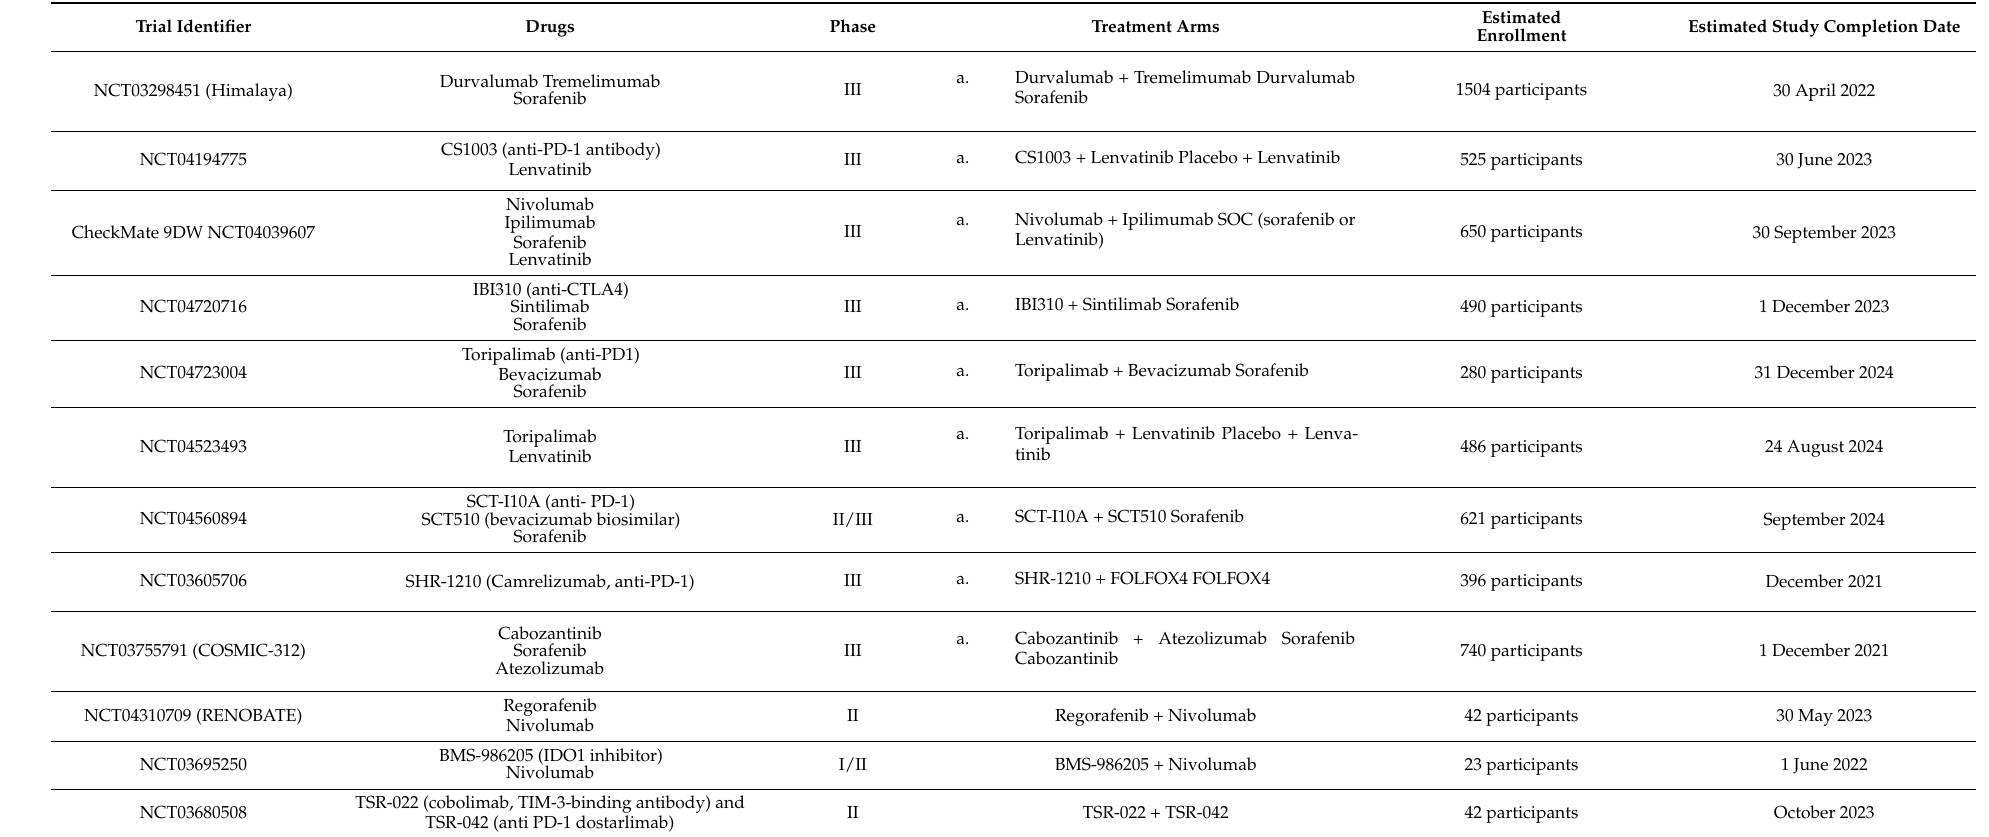
Table 1. Active phase III and II studies with ICIs in HCC patients who have not received prior systemic therapy